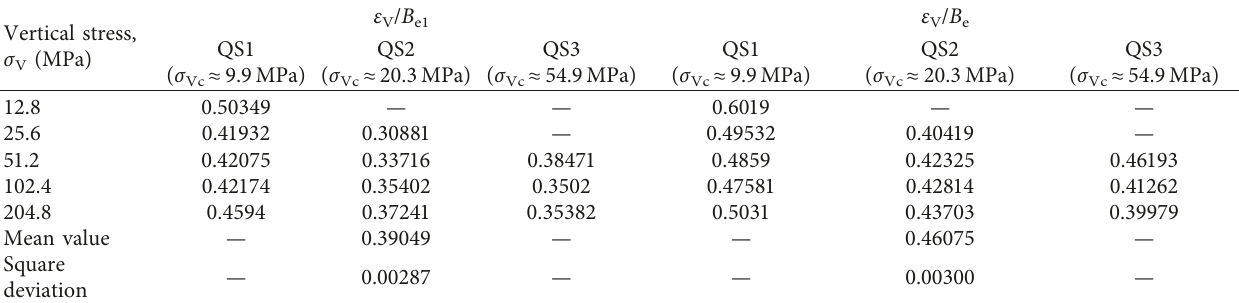
V / B e1 and ε V / B e for all types of specimens when σ V ≥ σ Vc .